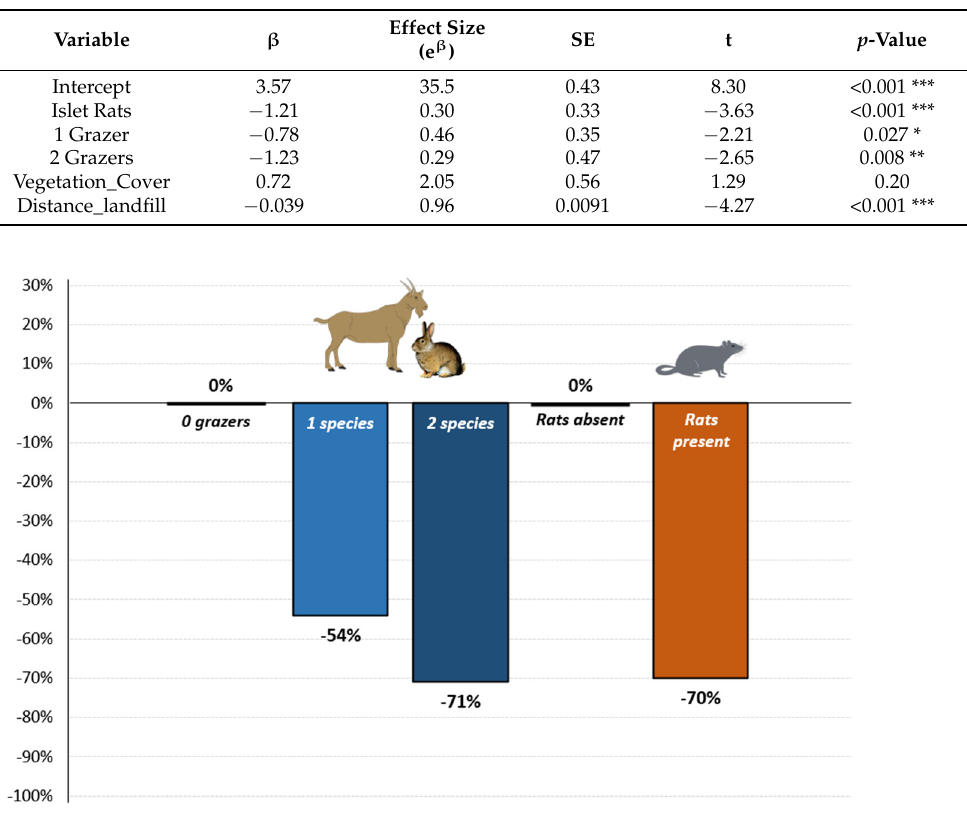
significant with a p -value less than 0.01, and those marked with three asterisks (***) are significant